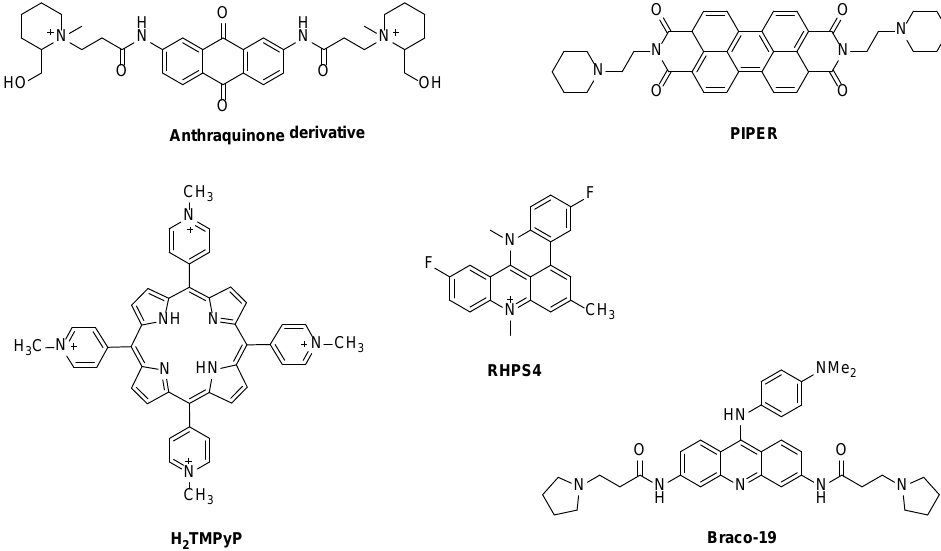
Figure 8. Examples of polycyclic ligands reported to inhibit telomerase activity. Amongst the aromatic macrocycles, porphyrins, such as the cationic H 2 TMPyP and analogs appear as the most widely tested telomerase inhibitors [32,33,53–55]. Structural attributes such as the presence of an extended heteroaromatic moiety that can interact on the G-quartet surface of a G-quadruplex by π − π stacking, and flexible cationic charged terminal side chains are pointed as essential features for effective ligand binding to a quadruplex and optimal inhibition of telomerase activity [9]. Other important structural characteristics are the presence of bulky substituents to prevent intercalation with double-stranded DNA and good solubility in aqueous media. In general, aromatic/planar molecules such as porphyrins and analogs, especially if positively charged, present good GQ stabilizing properties with high affinity for G-quadruplexes (K b ≥ 10 6 M − 1 , where K b corresponds to the binding constant) [56–58]. Ligands containing metals present higher interaction with G-quadruplexes due to stronger π - π interactions and/or coordination processes, thus being more selective for GQ [42,59]. A metal center can be predicted as a structural region that sets ligands